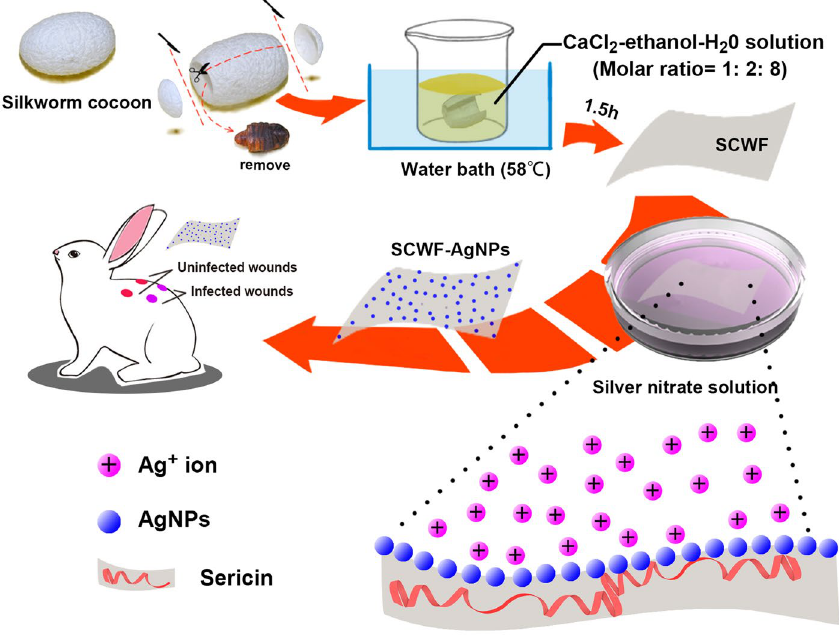
Figure 1. Illustration of the route of SCWF synthesis and the use of SCWF-AgNPs as a wound